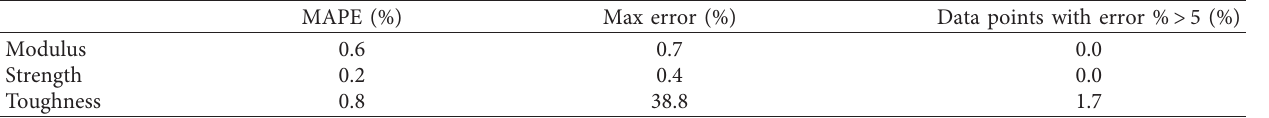
Table 2: CNN model performance for 8 × 8 grid.